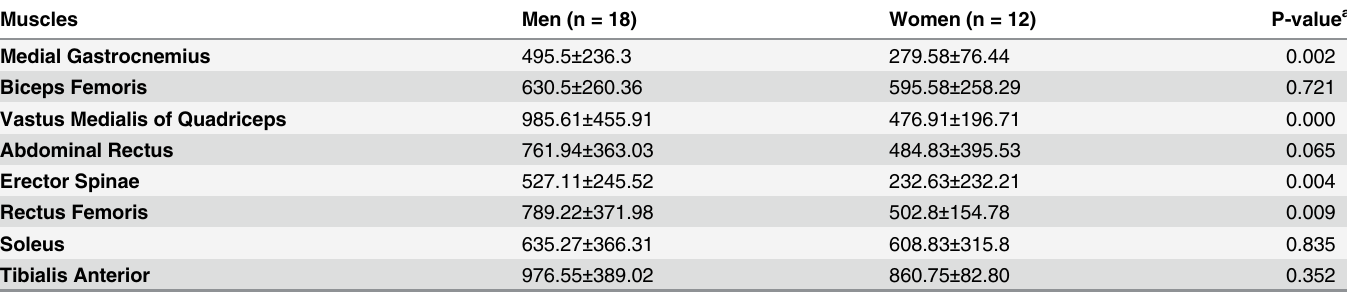
Table 2. Real activation ( μ V) obtained from MVC test (mean ± SD).